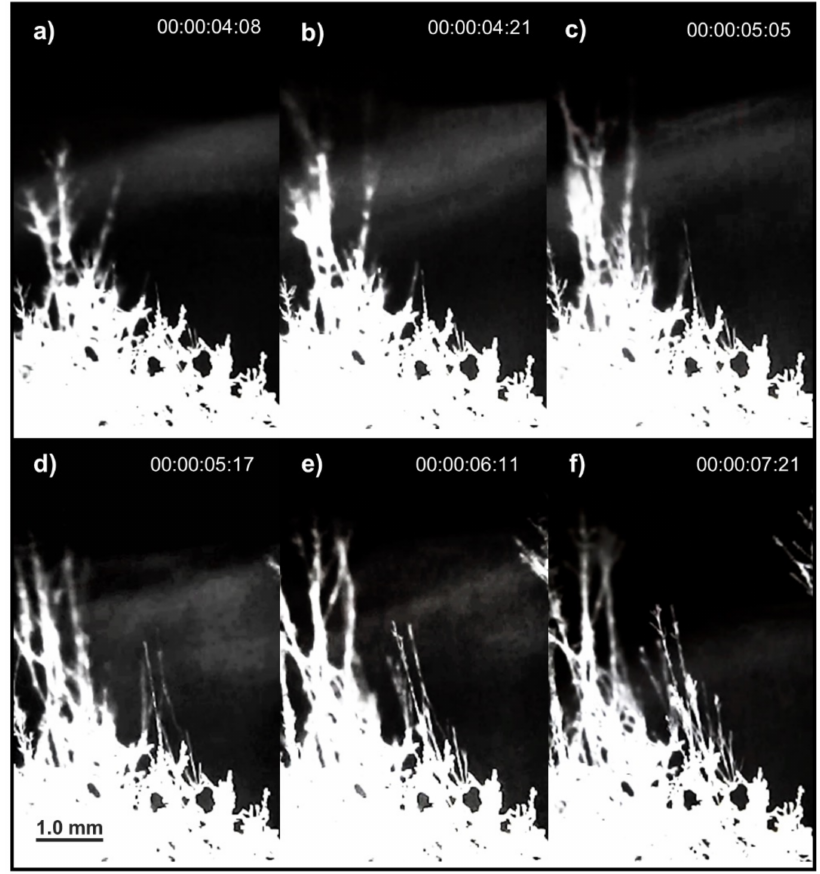
Figure 5. ( a – f ) Contrast-enhanced frames show the appearance of ice needles in the lower central part of each frame. Note that needles appear, and their contrast increases only in the presence of the supercooled water droplets appearing as a cloud in the background.